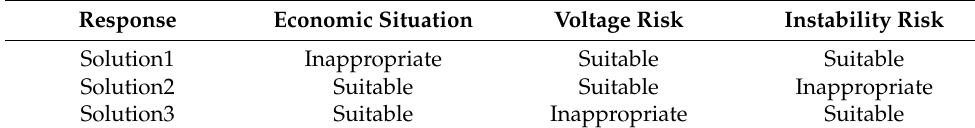
Table 4. The status of each response in terms of objective functions.